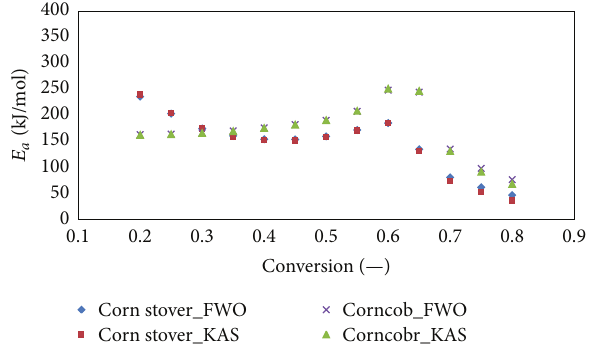
Figure 6: Variation of apparent activation energy of corn residues with conversion